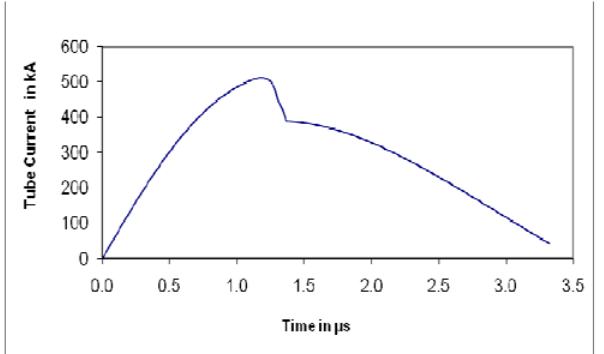
. Optimization carried out with 0 = 20 kV and model parameters f , f , f , f are 0 m c mr cr , v and v are the peak axial, radial a s p